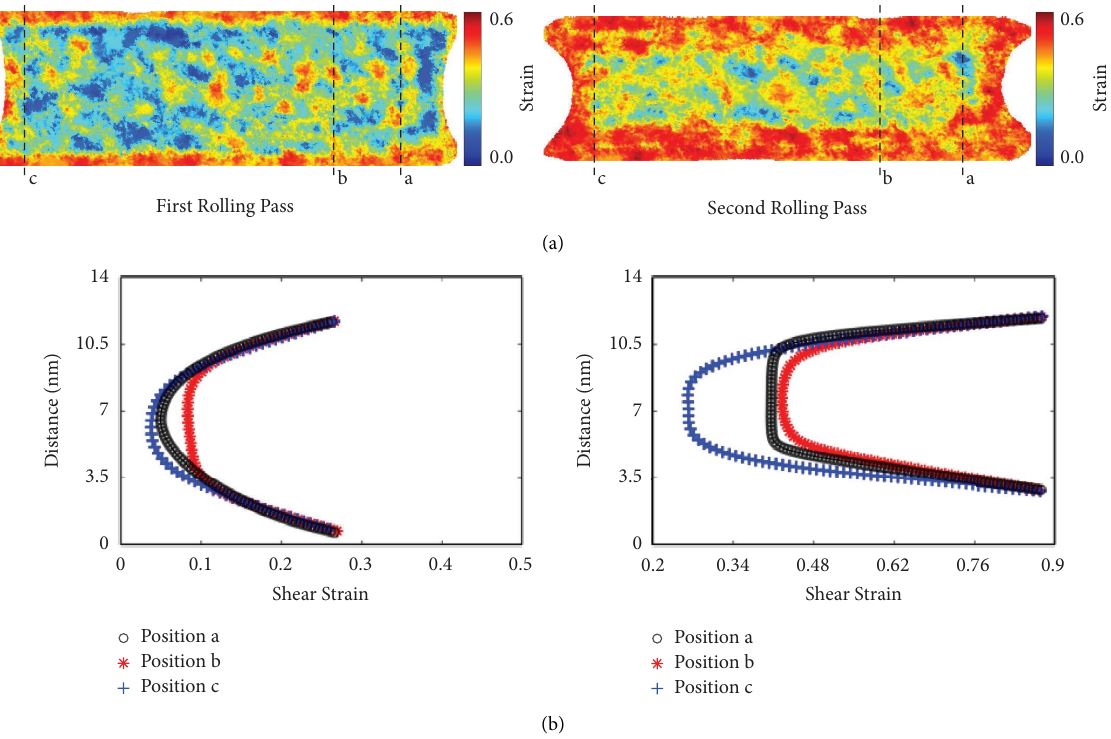
Figure 3: (a) Te snapshots of shear strain at the normal direction (ND) during the hot rolling, (b) the linear distribution of shear strain for selected Figure 3(a) indicates the shear strain snapshots of MG